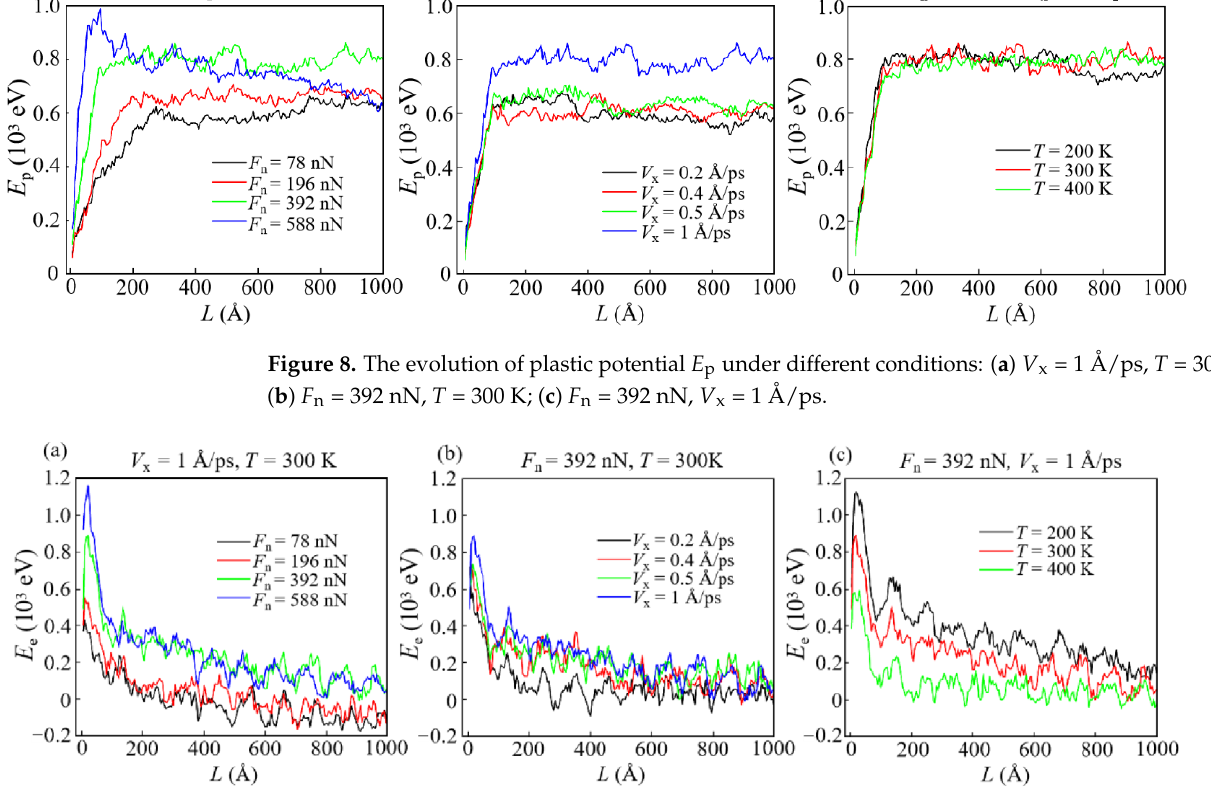
Figure 8. The evolution of plastic potential E p under different conditions : ( a ) V x = 1 Å /ps, T = 300 K; ( b ) F n = 392 nN, T = 300 K; ( c ) F n = 392 nN, V x = 1 Å /ps.